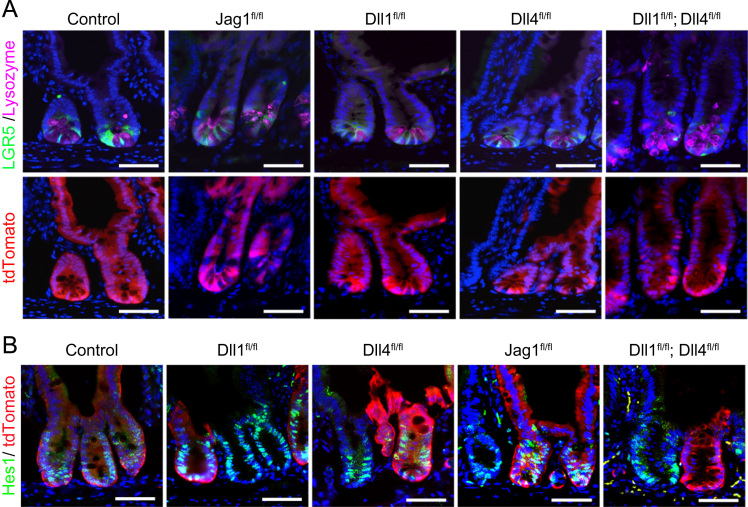
Stem cell niche structure and Hes1 expression in Jag1fl/fl mice, Dll1fl/fl mice, Dll4fl/fl mice, and Dll1fl/fl; Dll4fl/flmice. Small intestinal tissues of Jag1fl/fl mice, Dll1fl/fl mice, Dll4fl/fl mice, and Dll1fl/fl; Dll4fl/fl mice were collected at day 15 after TX induction for 5 consecutive days (Days 1–5). (A) The number and distribution of LGR5+ve cells (green, upper panel) and Lysozyme+ve cells (red, upper panel) in tdTomato+ve crypt-villus units (red, lower panel) were analyzed by immunostaining. Scale bar, 50 μm. (B) Expression of Hes1 (green) in the small intestinal crypts was analyzed by immunostaining. Red signals indicate tdTomato+ve cells. Scale bar, 50 μm.